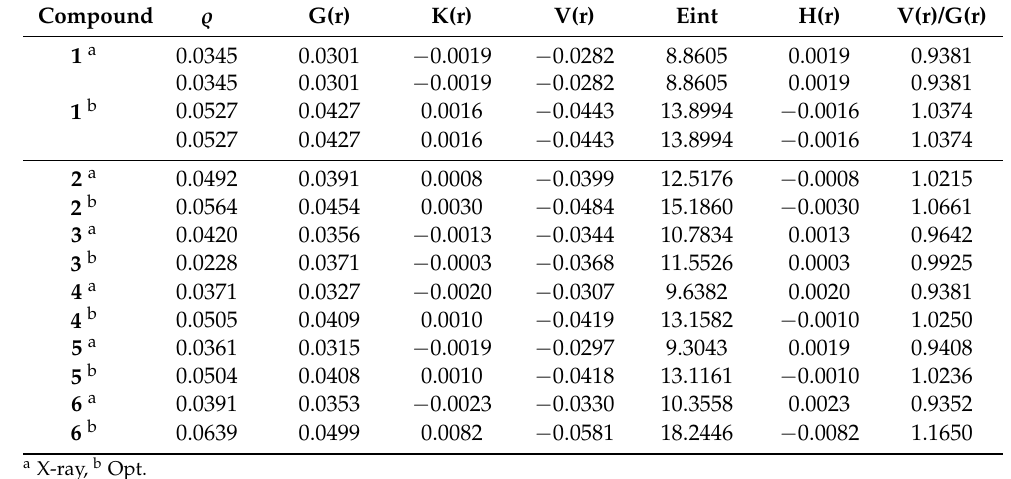
Table 7. The AIM results for the intramolecular O...H hydrogen bond in the studied compounds.